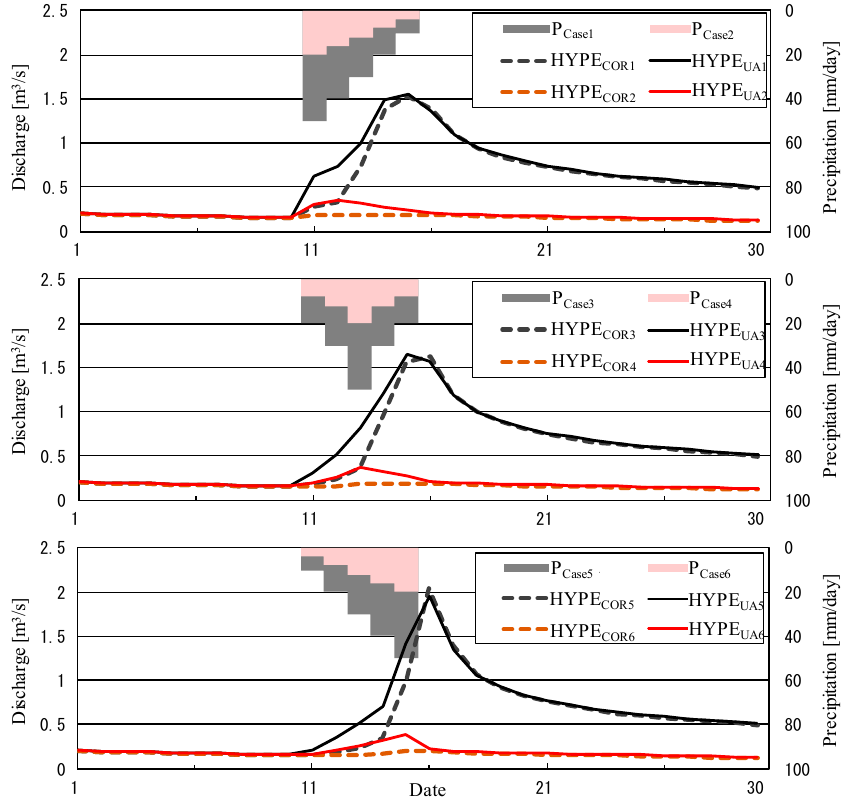
Figure 4. Hydrological characteristics of pervious and impervious surfaces, respectively.